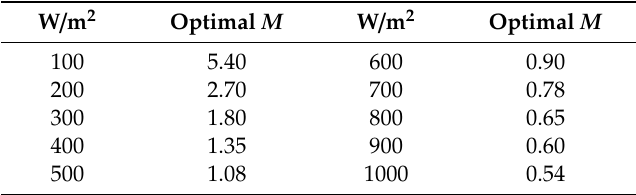
Table 3. The optimal scaling factor ( M ) for di ff erent irradiance